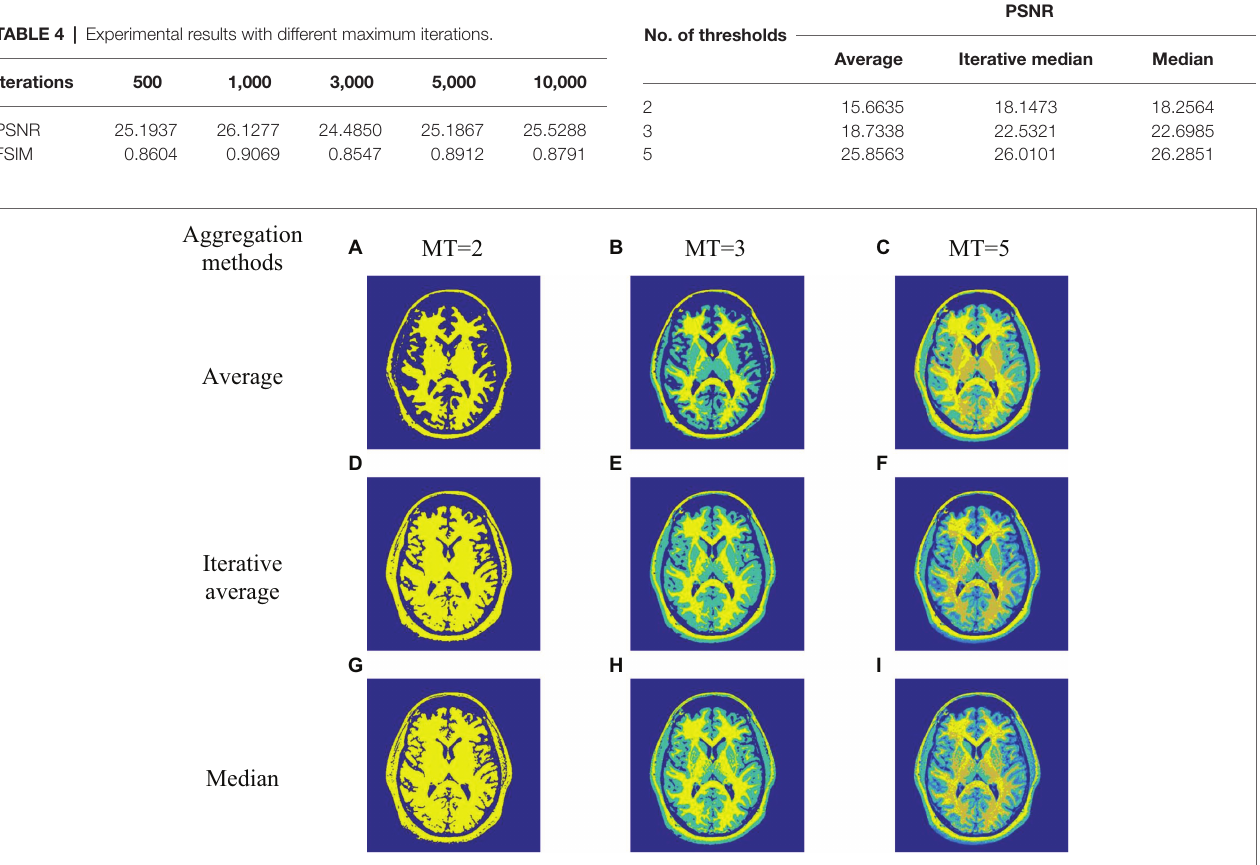
FIGURE 2 | Image segmentation effect of improved satin bowerbird optimizer (ISBO) based on three aggregation methods. (A-I) only characterize the serial numbers of different experimental images.